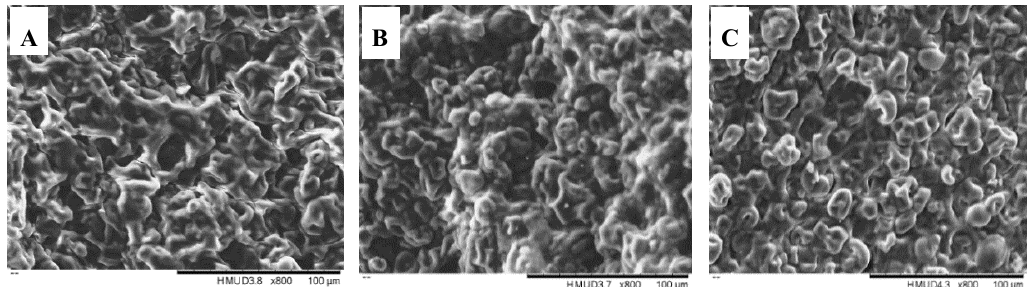
Figure 8. SEM image of the mixture systems ( × 800). ( A ) Test OF at a viscosity of 1.374 Pa · s, ( B ) Test 1 at a viscosity of 0.483 Pa · s, and ( C ) Test 24 at a viscosity of 2.058 Pa · s.